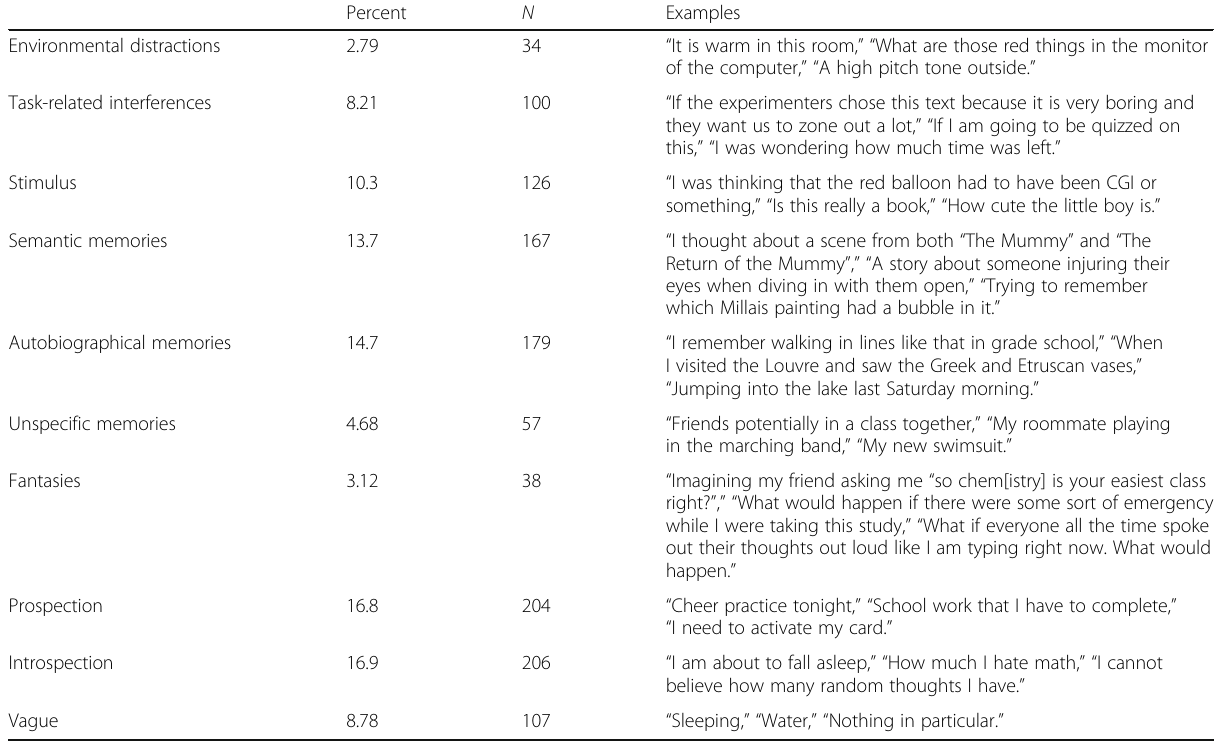
Table 1 Thought categories, frequencies, and examples Percent N Examples